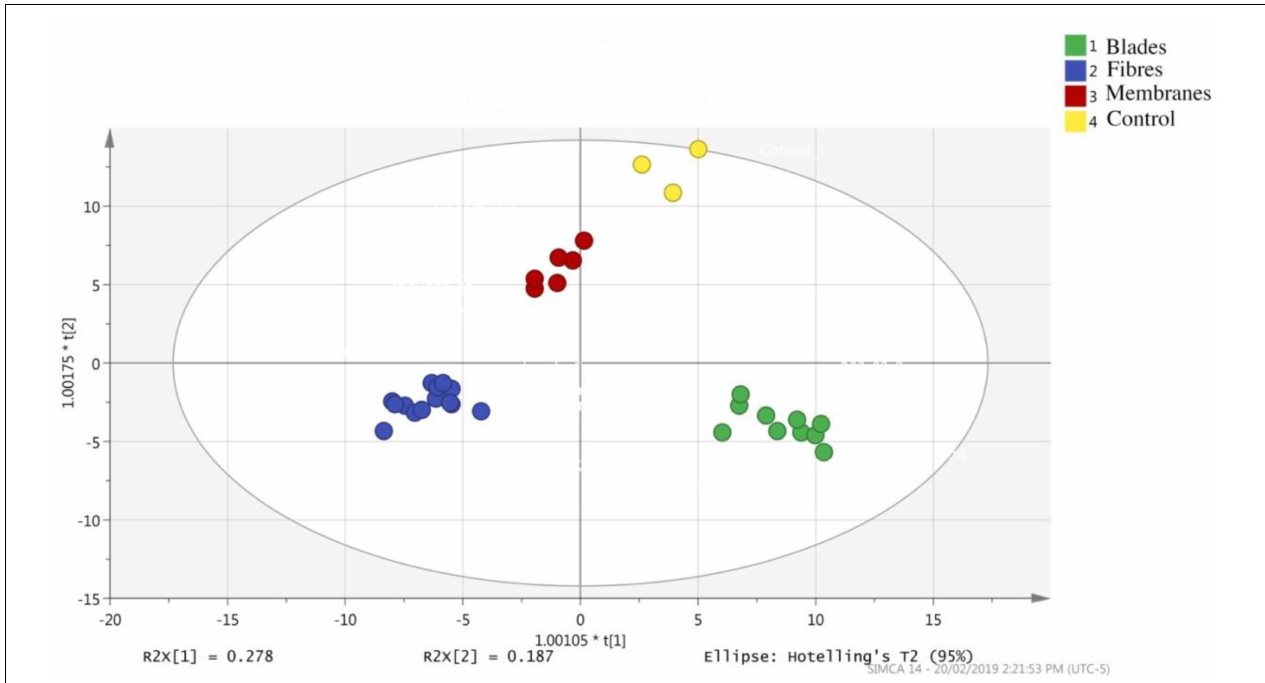
FIGURE 3 | Principal component analysis plot showing the separation of the features obtained by three different SPME devices: blades, fibers, and membranes, as well as the control (water